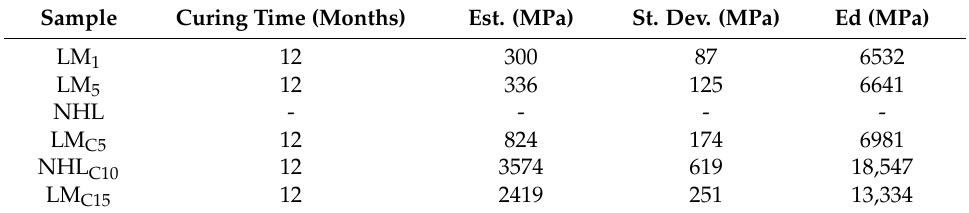
Table 8. Synthesis of selected restoration mortars